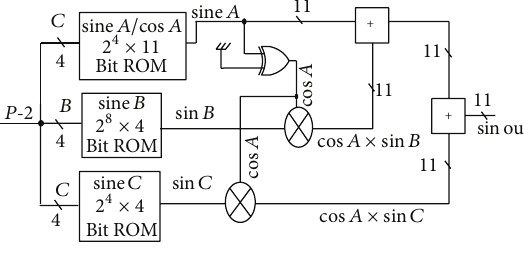
Figure 6: Architecture of compressed ROM LUT